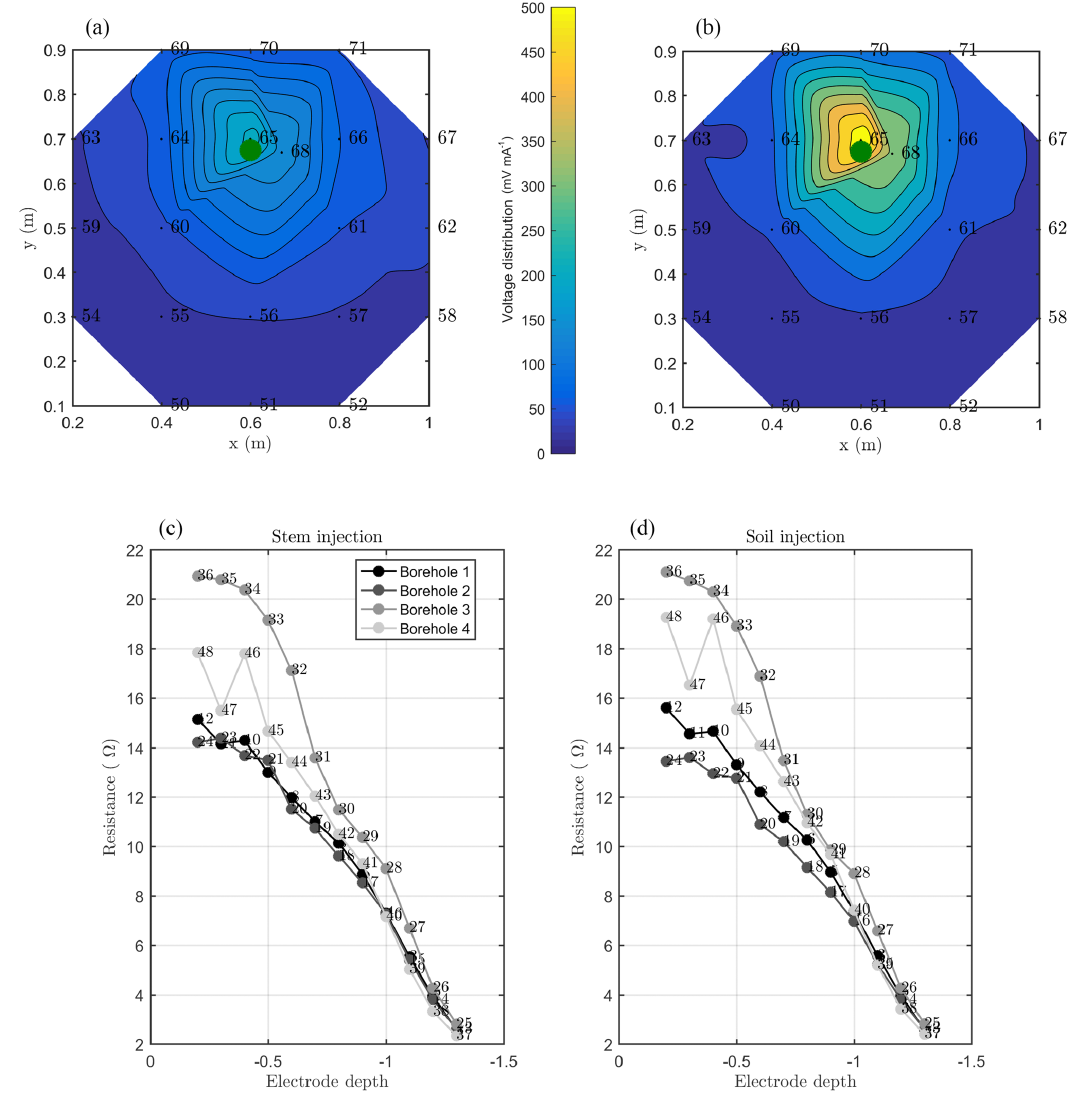
Figure 7. MALM acquisitions: spatial variations of the normalized voltage (in V/A) observed at surface and borehole electrodes. A compar- ison is shown between MALM voltage distributions when the current is injected into the soil (b, d) and into the stem (a, c) . The green points show the positions of the plant